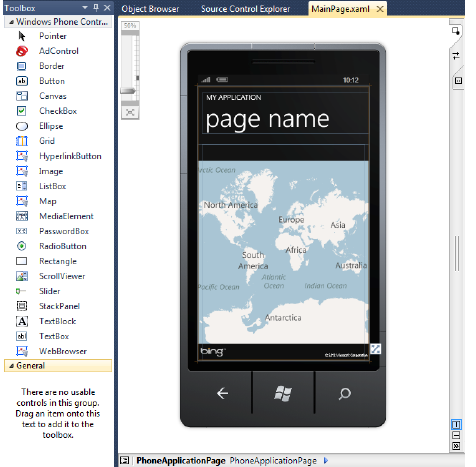
Figure 4 Toolbox and Design View for Windows Phone 7 Application Design using Silverlight™